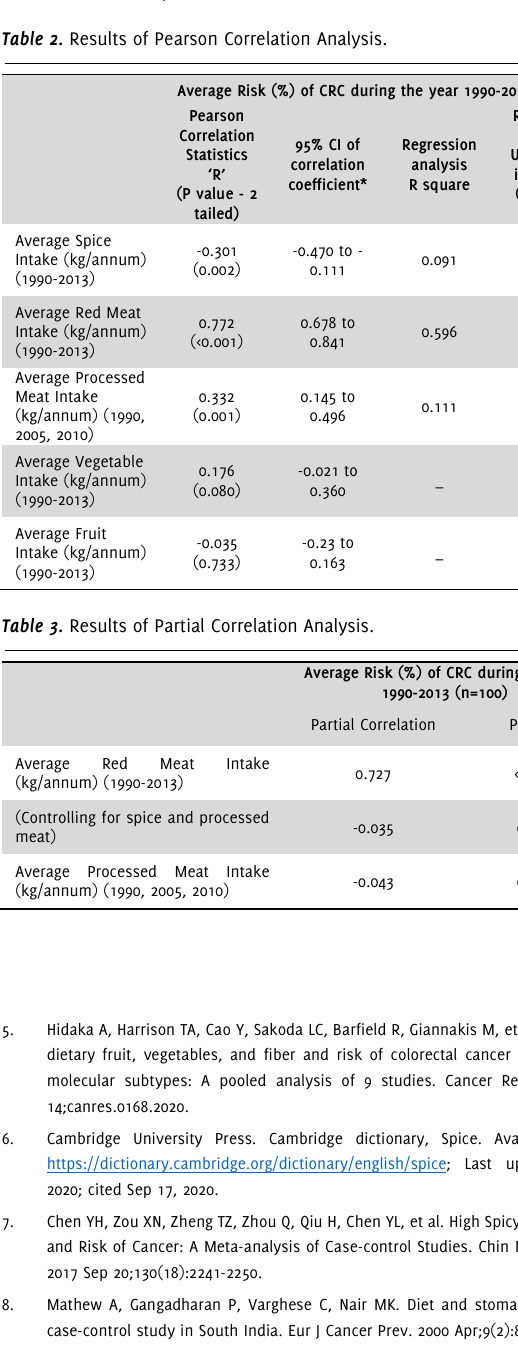
Table 2 . Results of Pearson Correlation Analysis.